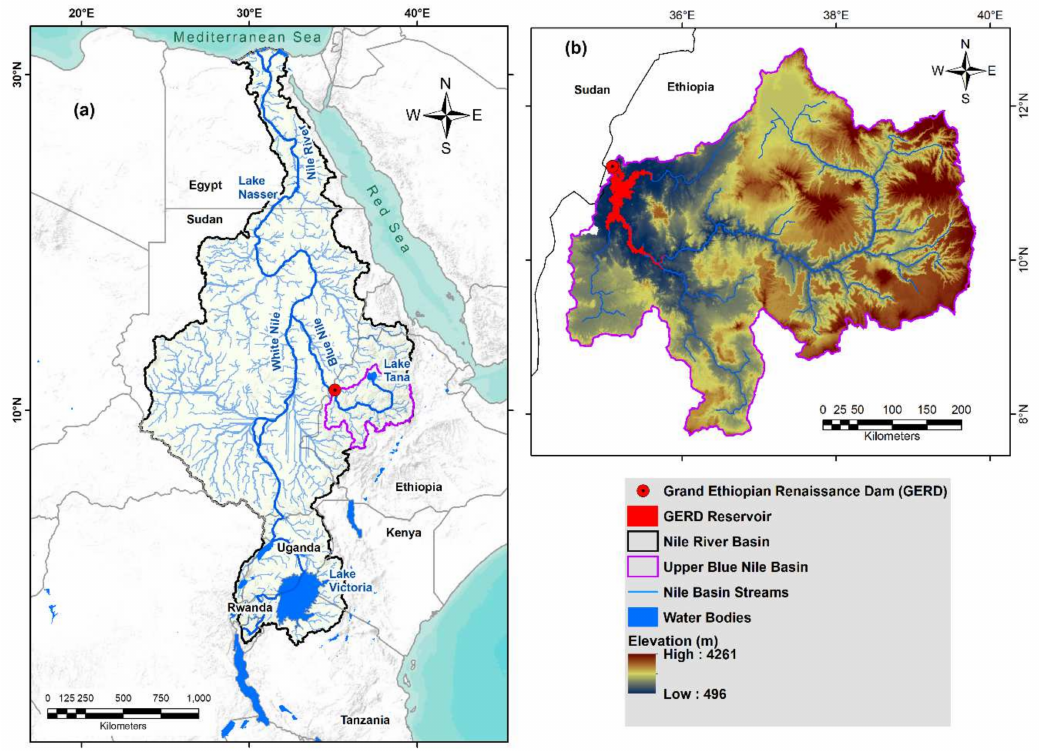
Figure 1. ( a ) Spatial distribution of the Nile River within the Nile River Basin (NRB) and location of the Grand Ethiopian Renaissance Dam (GERD), major lakes, and the Upper Blue Nile (UBN) sub-basin. ( b ) Digital elevation model (DEM) of the UBN sub-basin. The location of the 74 km 3 GERD reservoir is also